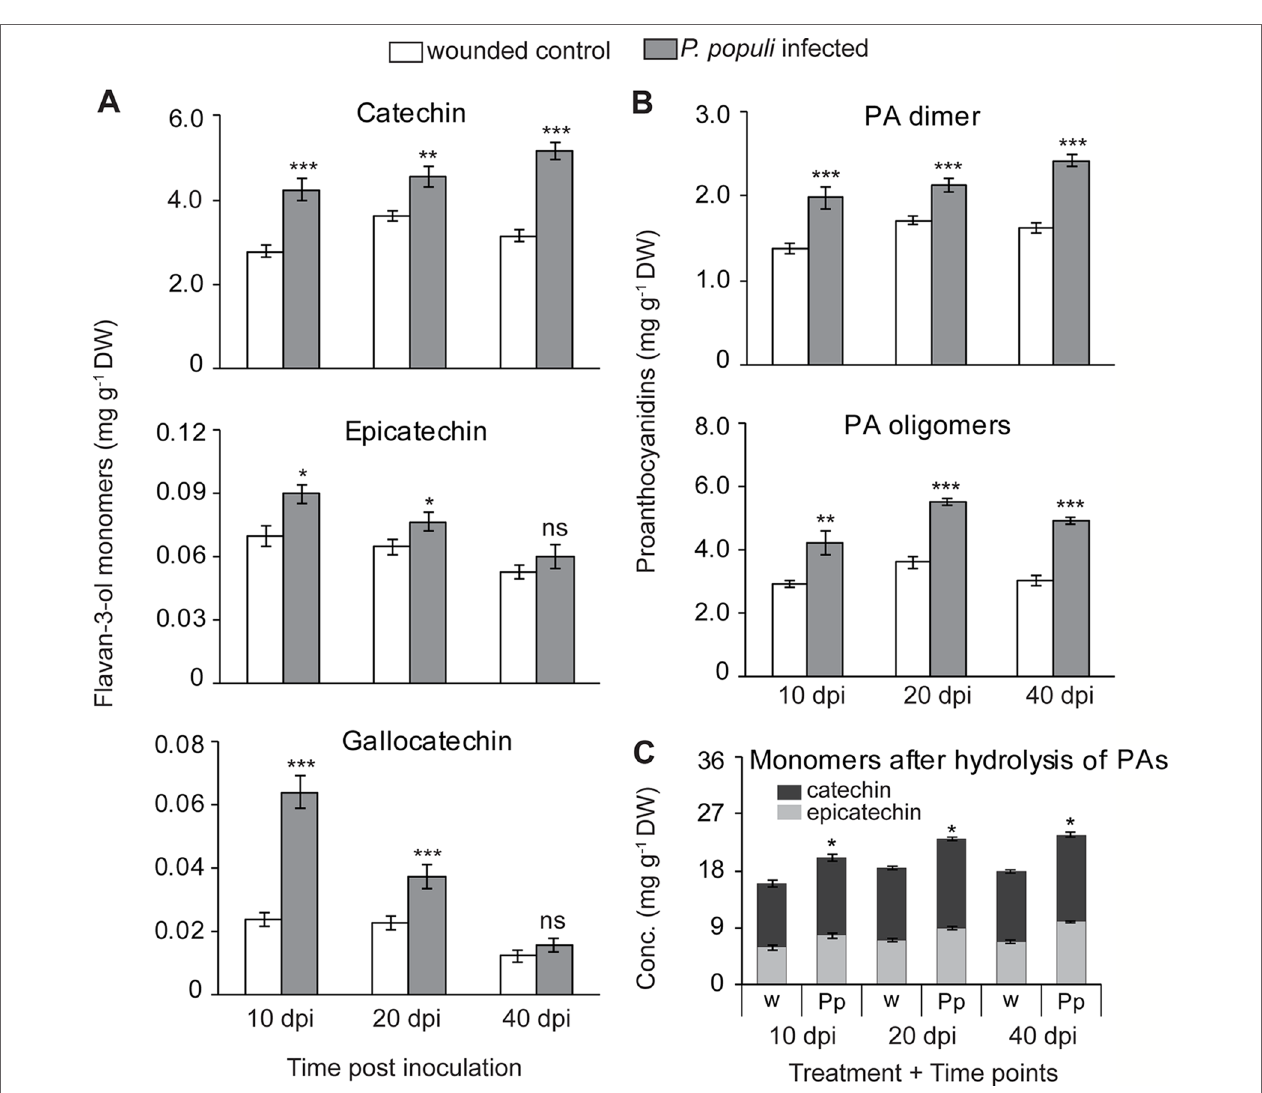
FIgURe 3 | Flavan-3-ol monomers and proanthocyanidins (PAs) accumulate in black poplar stems in response to infection by P. populi . Concentrations of (A) flavan-3-ol monomers, (B) PA dimers and oligomers, and (C) flavan-3-ol monomers after hydrolysis of PA oligomers. Trees approximately 1 m in height were inoculated with P. populi after wounding and control trees were inoculated with the culture medium only. Samples were harvested from separate trees at each time point. Catechin, gallocatechin, and PA dimers were analyzed by LC-tandem mass spectrometry. PA oligomers were measured by HPLC-FLD. The levels of PAs were calculated as catechin equivalents. Data were analyzed using Student’s t-test (*, p ≤ 0.05; **, p < 0.01; and ***, p < 0.001; ns, non-significant). Bars represent mean ± SE (n = 5). dpi, days post inoculation, DW, dry weight; w, wounded; Pp, P. populi .